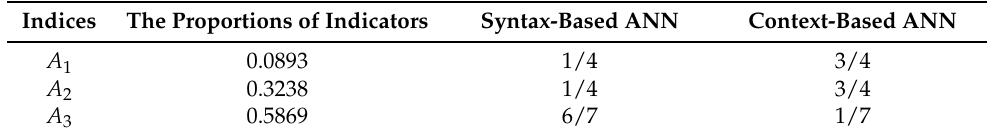
Table 7. The Proportion Between